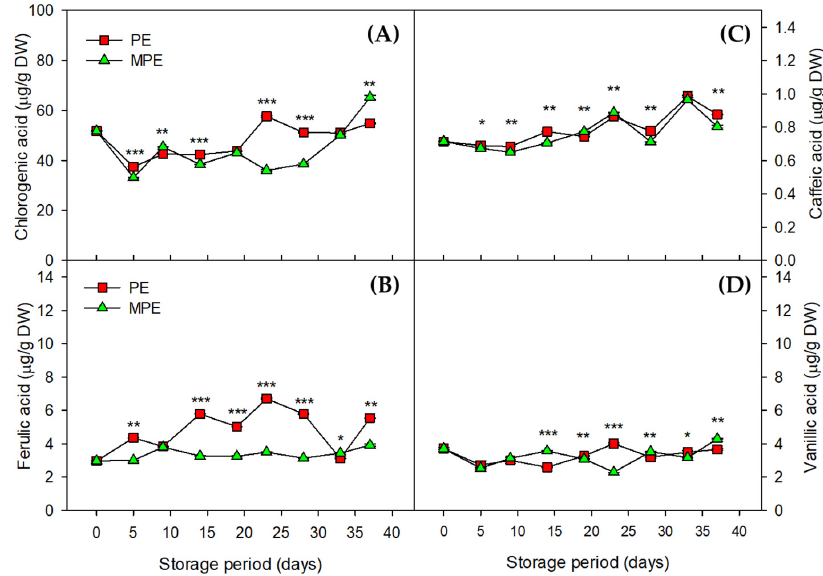
Figure 5. Changes in the phenolic acids of G. littoralis during storage at 4 °C. ( A ), chlorogenic acid; ( B ), ferulic acid; ( C ), caffeic acid; and ( D ), vanillic acid. MAP treatment was classified into micro-perforated PE (MPE, 32 pinholes) and PE on the basis of the presence or absence of pinholes, respectively. Values are shown as mean ± standard deviation. Statistical significance was shown by a t -test between PE and MPE at each time point during storage (*** p < 0.001, ** p < 0.01, and * p <